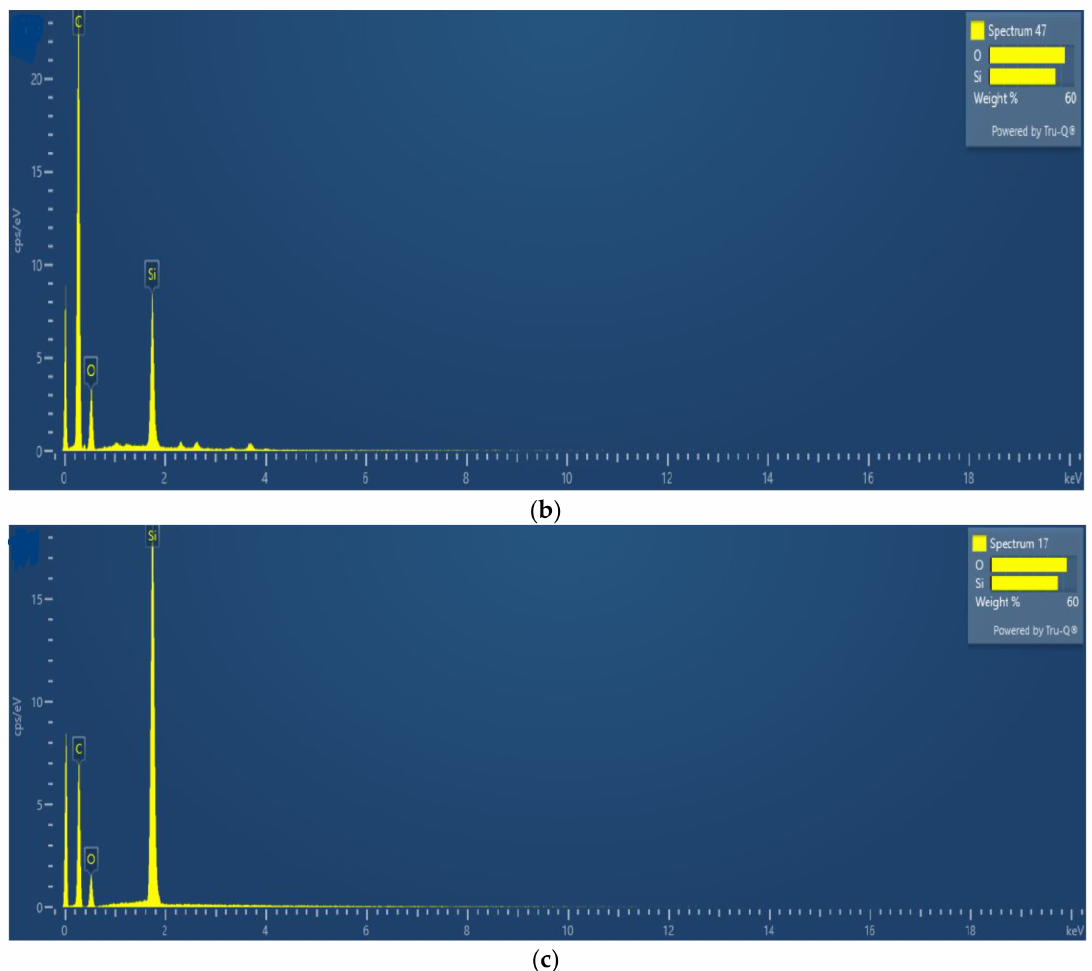
Figure 4. EDX elemental analysis spectra showing: ( a ) typical regions with high Si content for composites filled with neat silica and OTMS silica; ( b ) typical regions with low Si content for composites filled with neat silica and OTMS silica; and ( c ) typical regions for nanocomposites with MPS, ACPS, and their combinations between them and